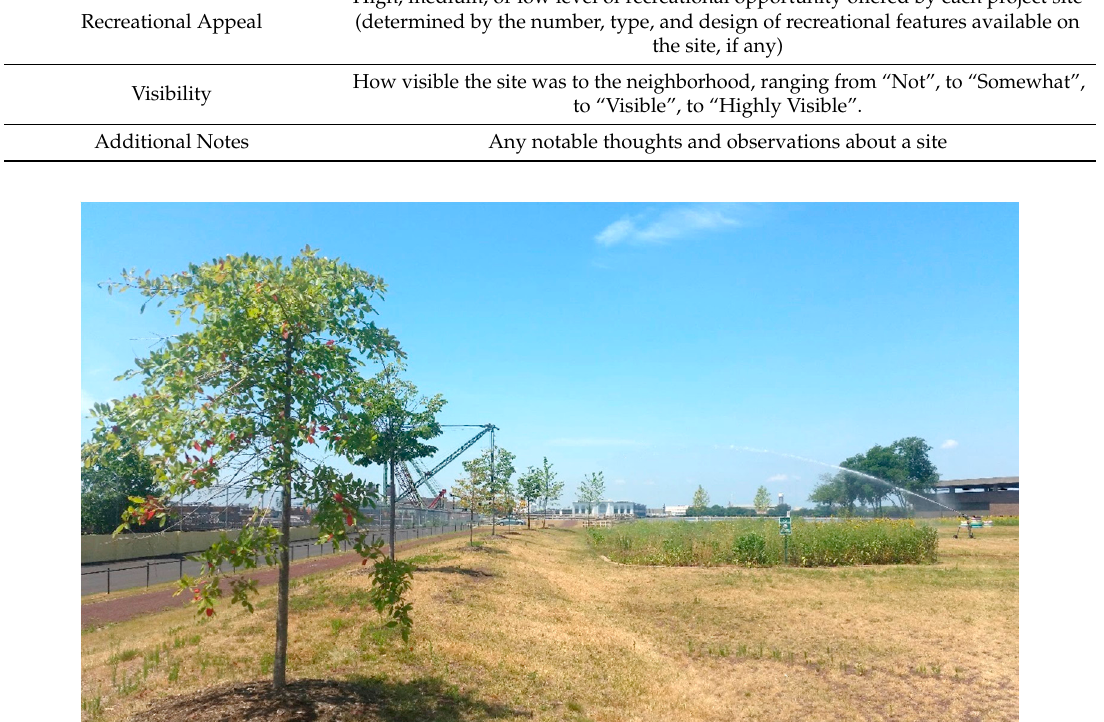
Figure 2. An example of a well-maintained GSI project in Camden. This 5.3-acre former Brownfield site was converted to a park to manage over 5 million gallons of stormwater annually [40]. The project, however, has visibility and access issues, as reported by local residents. Photo by Mahbubur Meenar.